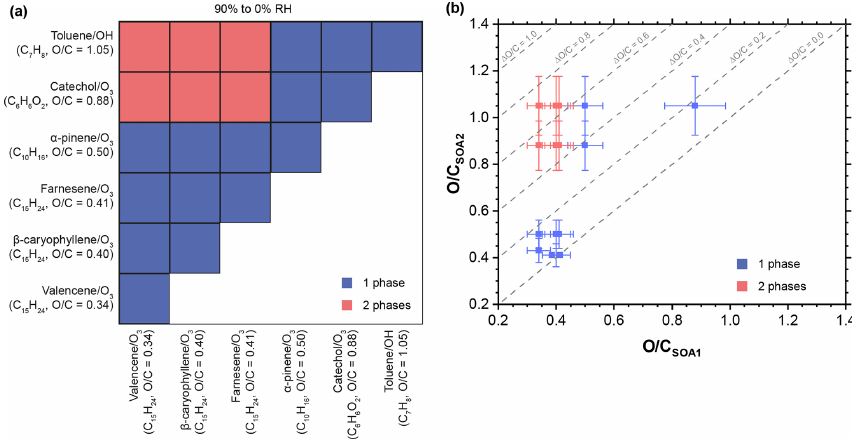
Figure 3. Summary of phase behavior of internal mixtures of two different types of SOA materials. (a) Experimental matrix showing the number of (non-crystalline) phases for the SOA + SOA mixtures studied for RHs between 90% and 0%. Given along with each SOA type is the average elemental oxygen-to-carbon (O / C) ratio, the chemical formula of the precursor gas, and the oxidant used to oxidize the precursor. (b) Number of phases observed for RH between 90% and 0% for the SOA + SOA particles as a function of the average O / C ratio of the two SOA types. Error bars indicate the 12% relative uncertainty of the average O / C ratio of each SOA type (average absolute value of relative error for multi-species organic aerosol, Canagaratna et al., 2015), as determined with the aerosol mass spectrometer (Table S3). The dotted lines indicate isolines of the differences in the average O / C of two SOA types within a mixture, (cid:49) (O / C), and are given for intervals of (cid:49) (O / C) = 0 . 2. In all the panels, blue and rose symbols mark internal SOA + SOA mixtures with one and two phases, respectively. See Figs. S6–S10 for fluorescence images of all SOA + SOA